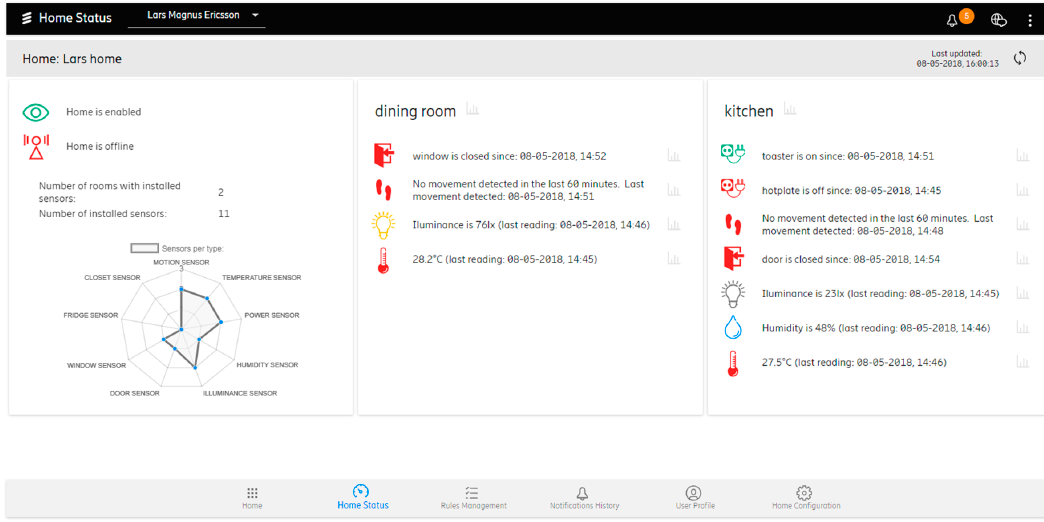
Figure 5. The home status view.